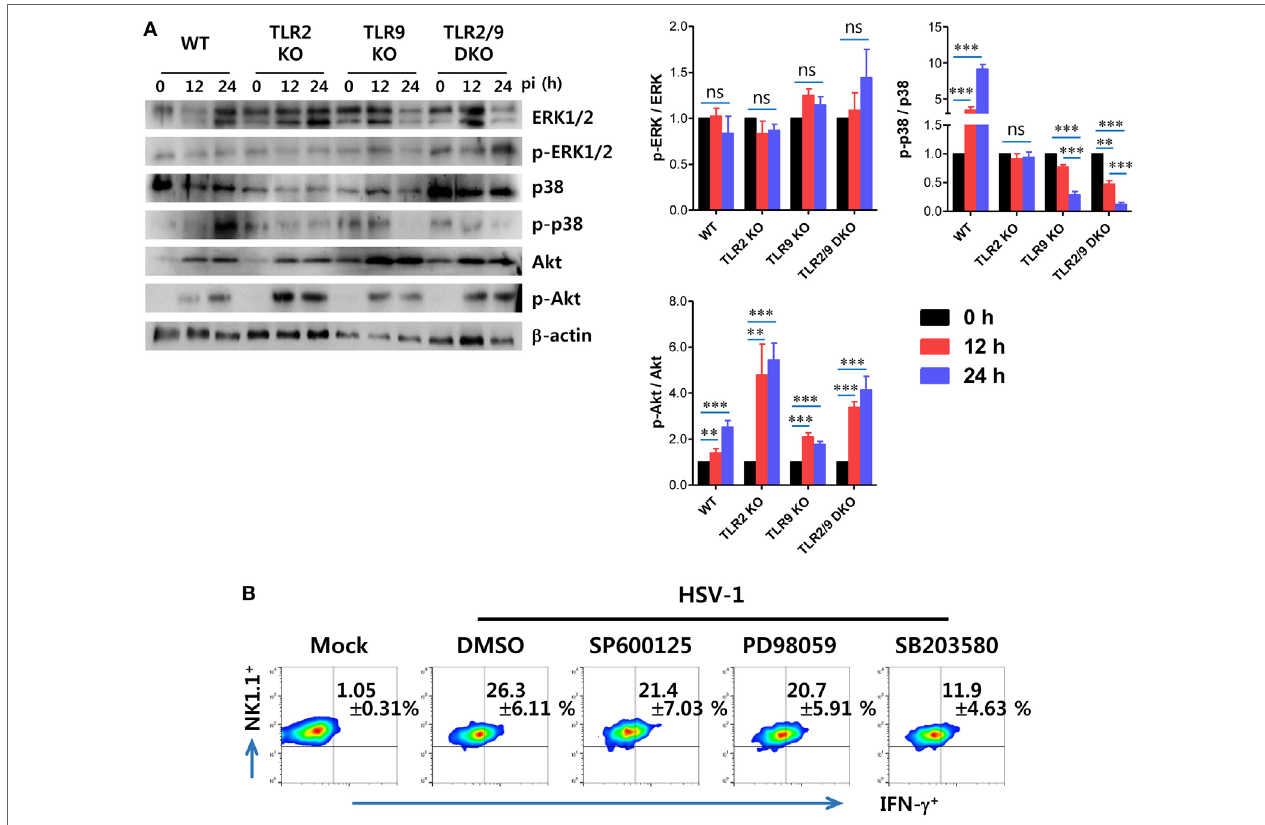
FigUre 10 | Direct TLR2/9-dependent activation of NK cells by herpes simplex virus (HSV)-1 is mediated by p38 MAPK. (a) Phosphorylation of MAPKs in HSV-1 infected NK cells. NK cells purified from the spleen (Spl) of wild-type (WT), TLR2 KO, TLR9 KO, and TLR2/9 double knock-out (TLR2/9 DKO) mice were infected with HSV-1 (5.0 moi). Western immunoblot was used for detecting unphosphorylated and phosphorylated forms of target MAPKs using specific Abs at the indicated time points. The luminescence intensities of Western blot bands were expressed by relative fold intensity compared with uninfected NK cells. (B) Dependence of HSV-1-mediated NK cell activation on p38 MAPK. NK cells purified from the Spl of WT mice were infected with HSV-1 in the presence or absence of a JNK inhibitor (SP600125), MEK inhibitor (PD98059), and p38 inhibitor (SB203580). NK cell activation was evaluated by intracellular IFN- γ staining 24 h later. The values in the plots represent the percentage of IFN- γ -producing cells in NK1.1 + cells after gating on CD3 - NK1.1 + DX5 + NK cells. Data in bar graphs and the plots denote the average ± SEM of values derived from at least three independent experiments ( n = 4–5). Two-way ANOVA followed by Bonferroni post hoc testing was conducted for the comparison of luminescence intensities in (B) . Data shown are representative of three independent experiments ( n =